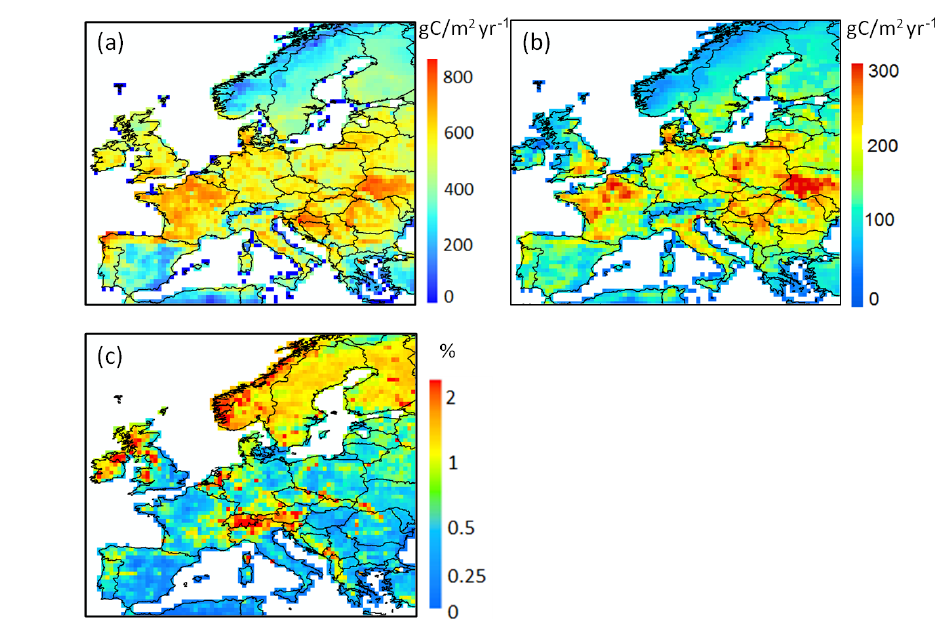
Figure 14. Grid-cell average of (a) net primary production (NPP), (b) net ecosystem exchange (NEE) and (c) fraction of NPP leached into the river network as DOC (%) for the period